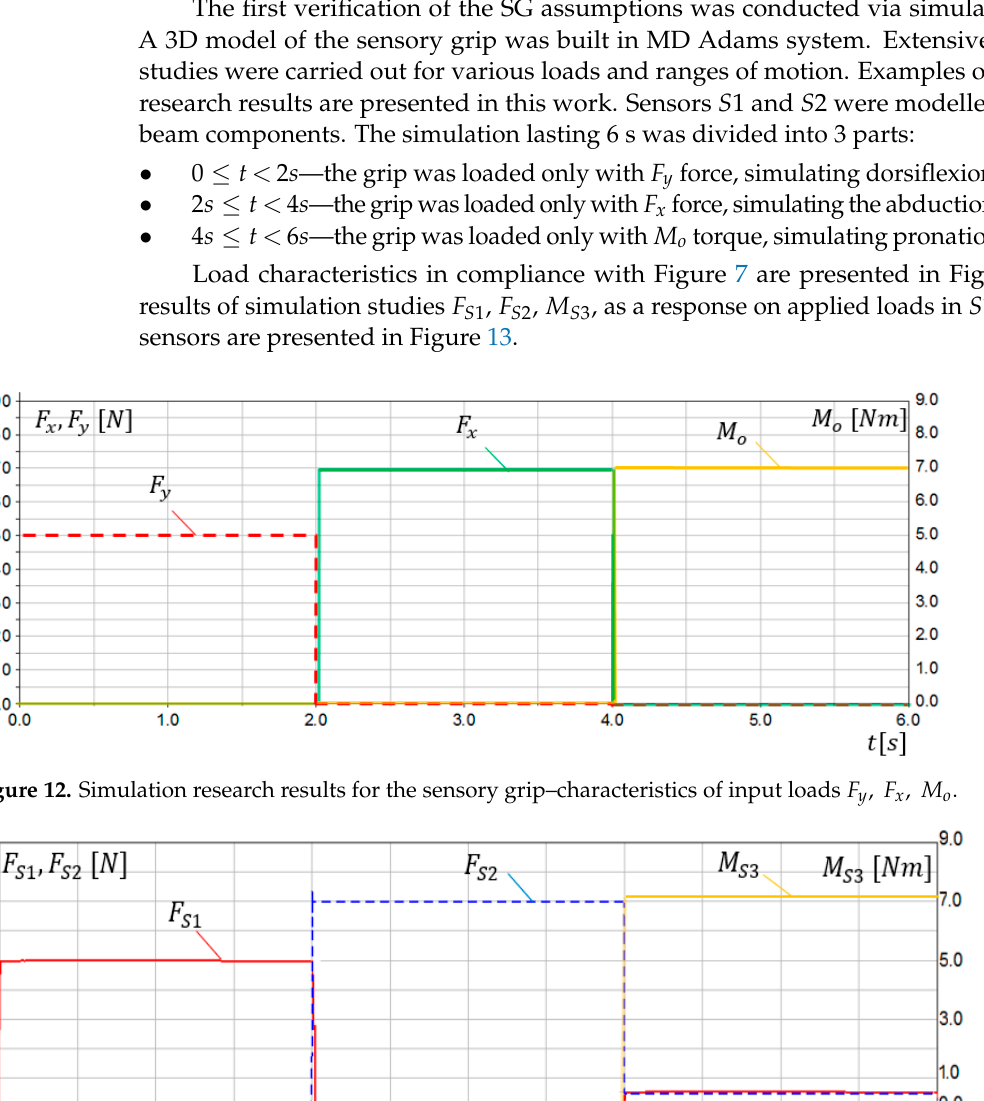
Sensors 2021 , 21 , x FOR PEER REVIEW